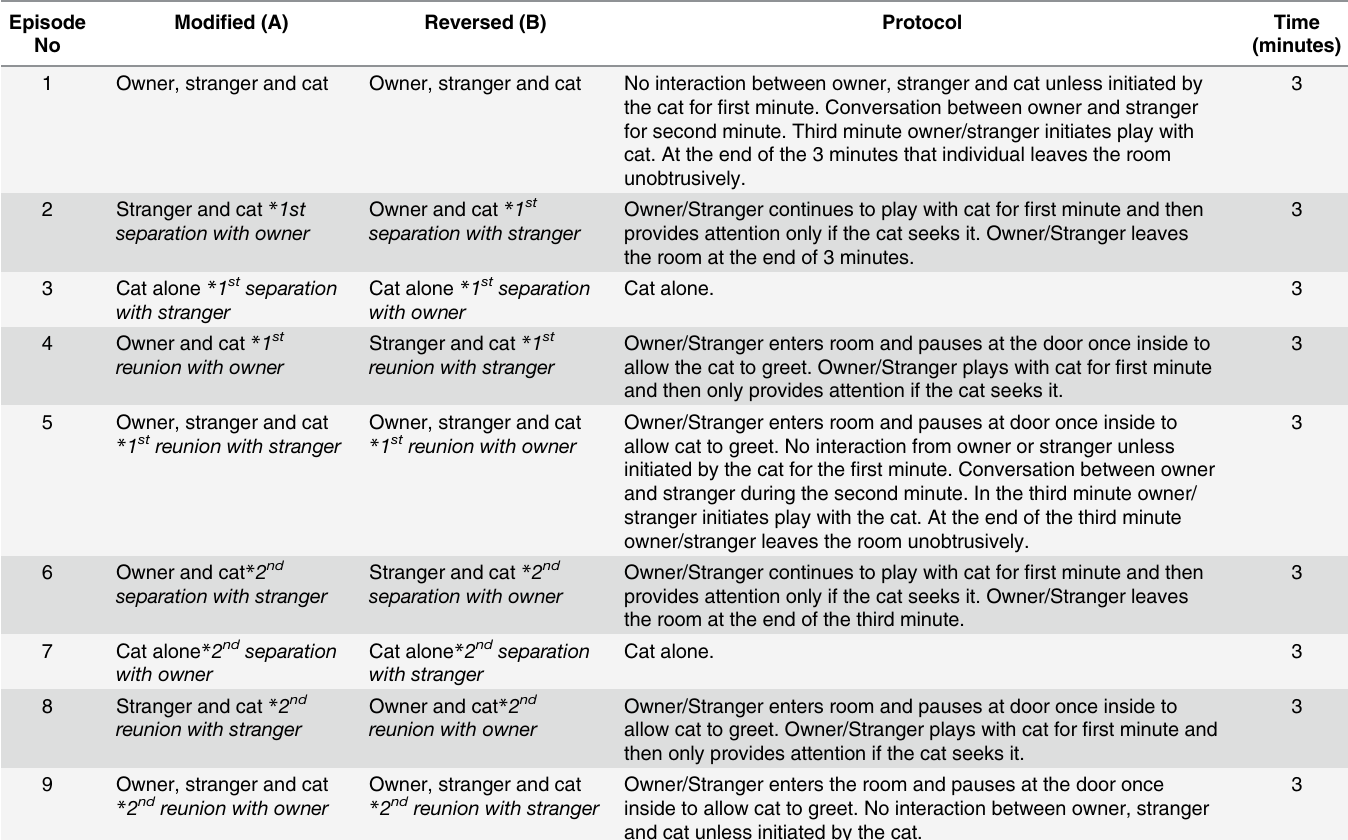
Table 1. Outline of episode sequence and protocol for the modified (A) and reversed (B) Strange Situation Test conditions. The following effects across the episodes would be consistent with secure attachment towards the carer over the social control (stranger); increased passive behaviour, explora- tion and social play in the presence of the carer; greater seeking of proximity and attempts to maintain proximity/contact with the carer; greater vocalisation when separated from the carer; increased vigilance and orientation to the door when the carer is